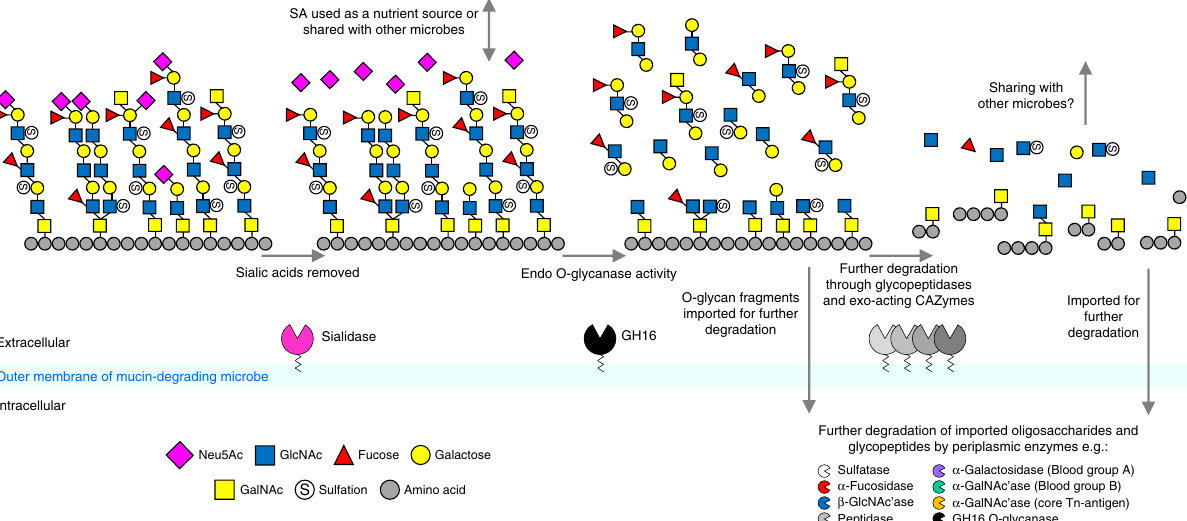
Fig. 8 Model for the role of GH16 O-glycanases in mucin breakdown. A model of the initial steps of mucin degradation on the surface of Bacteroides spp . and A. muciniphila . Sialic acid is removed by surface-localised sialidases and the GH16 enzymes remove oligosaccharides for import into the periplasm for further degradation by other CAZymes, including periplasmic GH16 O-glycanases. In Bacteroides species, glycan import is via energy dependent SusCD-like complexes, but in A. muciniphila the mechanism of glycan import across the outer membrane is unknown. The remaining mucin glycoprotein is likely further degraded by other extracellular CAZymes and glycopeptidases 19,29,50